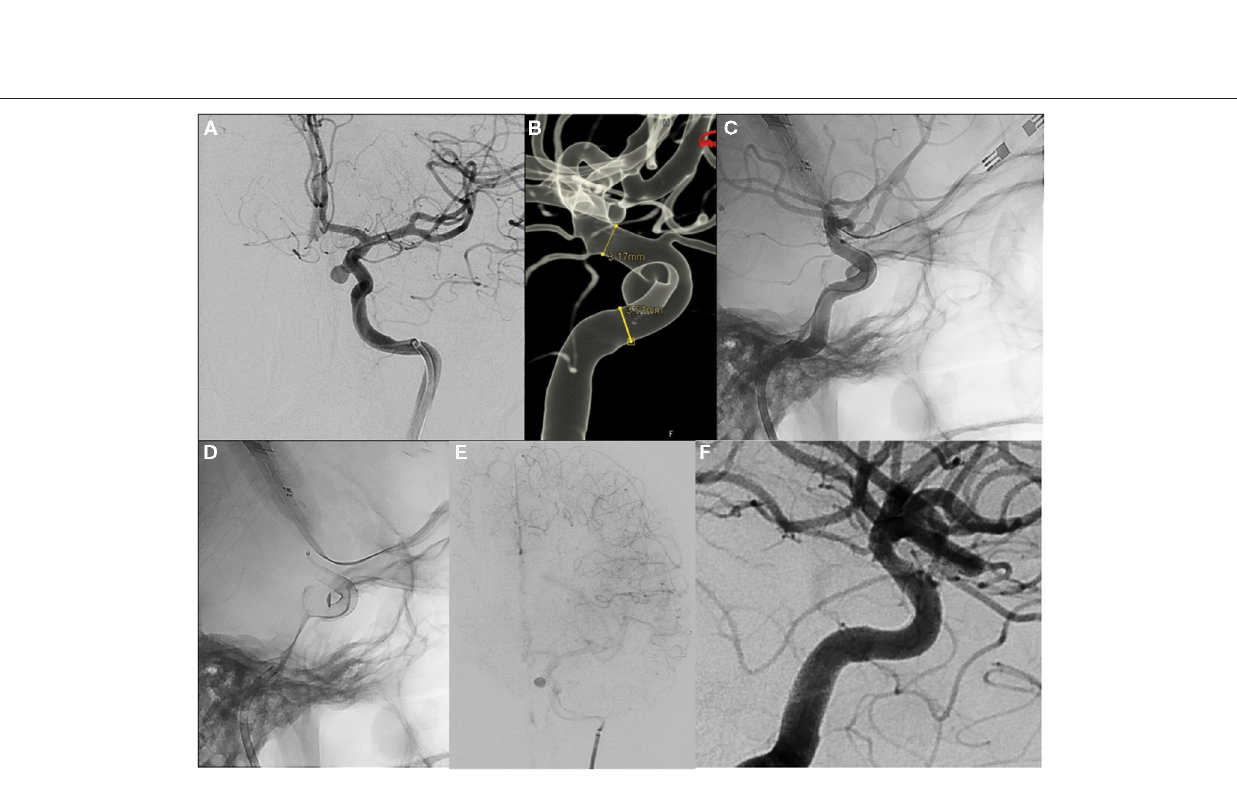
Frontiers in Neurology | www.frontiersin.org 3 July 2021 | Volume 12 | Article